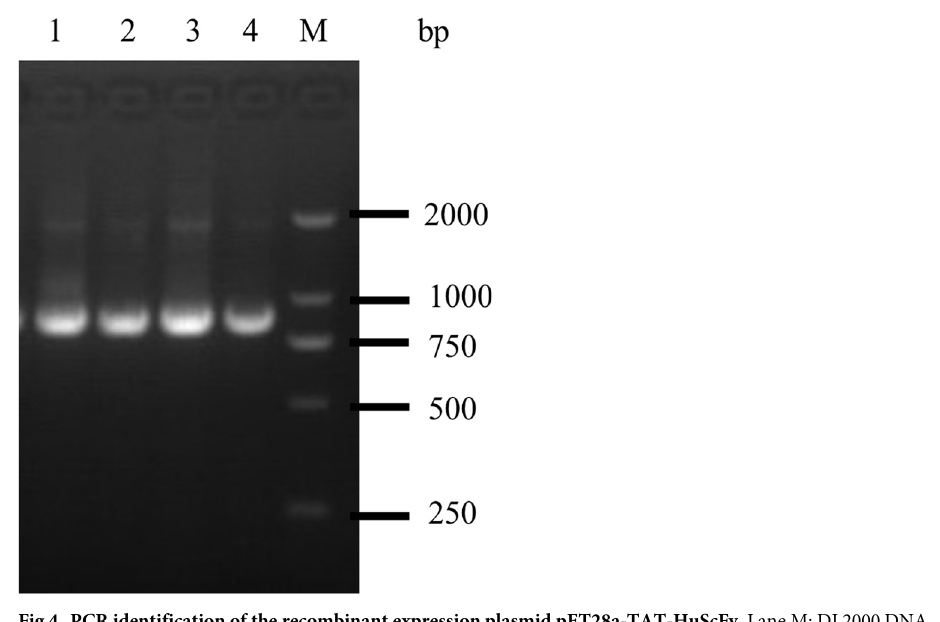
Fig 4. PCR identification of the recombinant expression plasmid pET28a-TAT-HuScFv. Lane M: DL2000 DNA marker; lanes 1 and 4: PCR product for the recombinant expression plasmid p ET-28a-TAT-HuScFv.